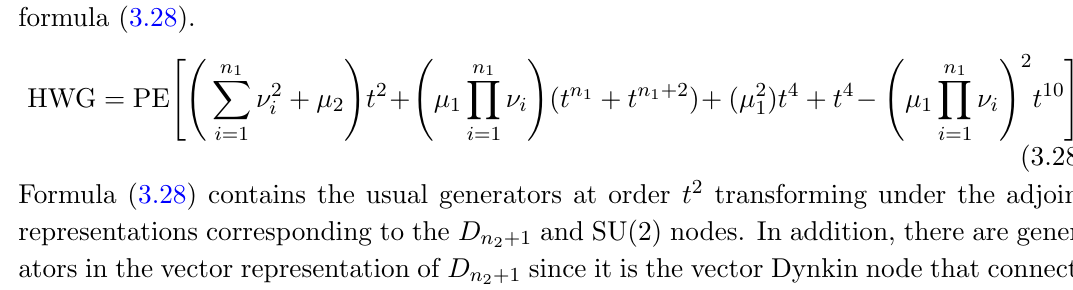
( n ), P (2) g quiver theories takes the form given by the general 1 [1 n 1 ] [1 2 ]